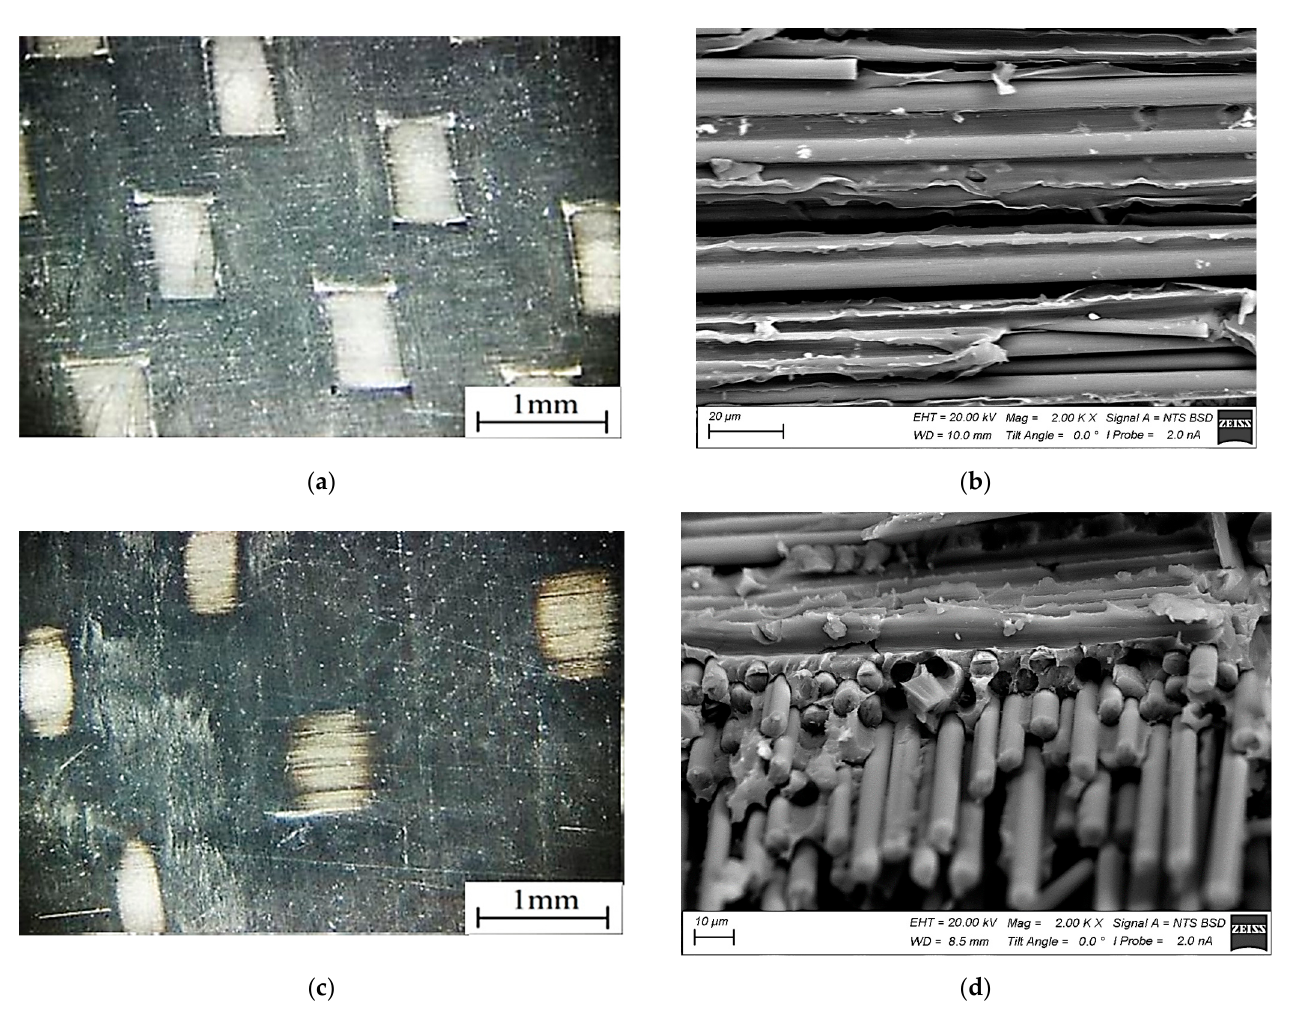
Figure 3. The general views from the surfaces ( a , c ), as well as the SEM micrographs of the cross- sections ( b , d ) of the prepregs from the annealed CFF impregnated with the PES ( a , b ) and the PEI ( c , d ). Table 2. The mechanical and dimensional properties of the USW lap joints obtained at t = 1000 ms, P = 1.5 atm, and τ = 5000